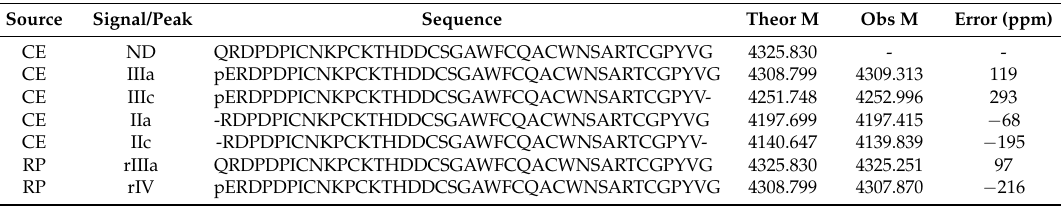
Table 2. Summary of the different chuPCI molecular species observed in the MALDI-TOF mass spectrometric analysis of the crude extract and purified